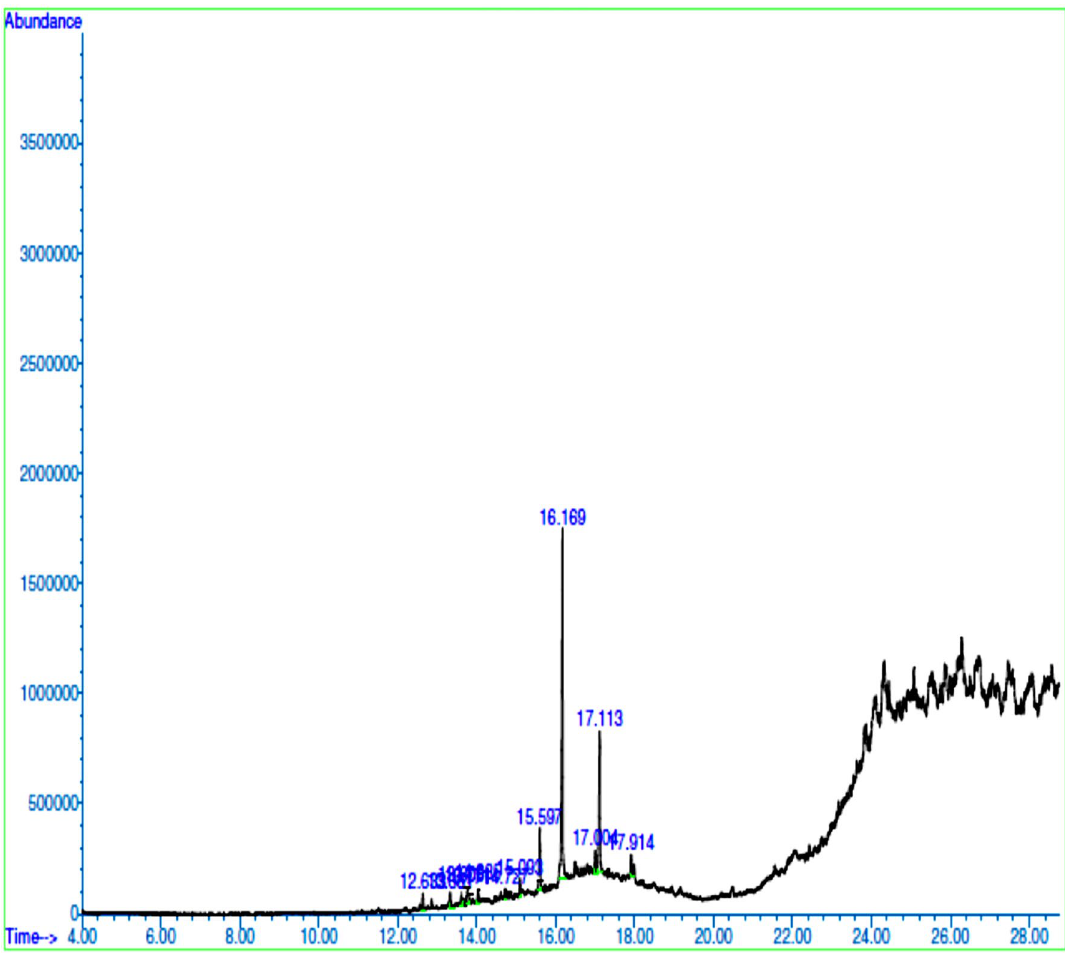
Figure 2. GC–MS chromatogram of Piper guineense seed